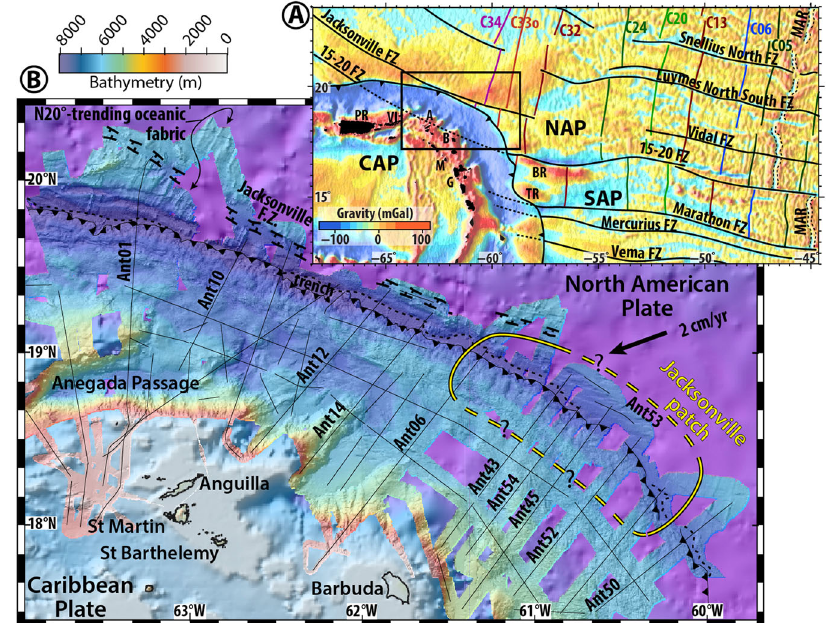
Fig. 1 Maps of the study area. A Satellite free-air gravity map 62 showing fracture zones (solid lines), synthetic fl ow lines (colored lines), and the Mid- Atlantic Ridge (dotted lines) in the Central Atlantic for chrons 5 (8.9 Ma), 6 (19.4 Ma), 13 (35.3 Ma), 20 (44.7 Ma), 24 (55 Ma) 32 (71.6 Ma), 33o (80.2 Ma), and 34 (84 Ma) 63 . A stands for Anegada, B for Barbuda, BR for Barracuda Ridge, CAP for Caribbean Plate, FZ for Fracture Zone, G for Guadeloupe, M for Montserrat, MAR for Mid-Atlantic Ridge, NAP for North American Plate, TR for Tiburon Ridge, PR for Puerto-Rico, SAP South American Plate, and VI for Virgin Island. The black frame refers to Fig. 1B. B Bathymetric map showing location for multichannel seismic lines labeled AntXX and the Jacksonville Fracture Zone (dashed black lines). Close-up on target zones are in Supplementary Fig.